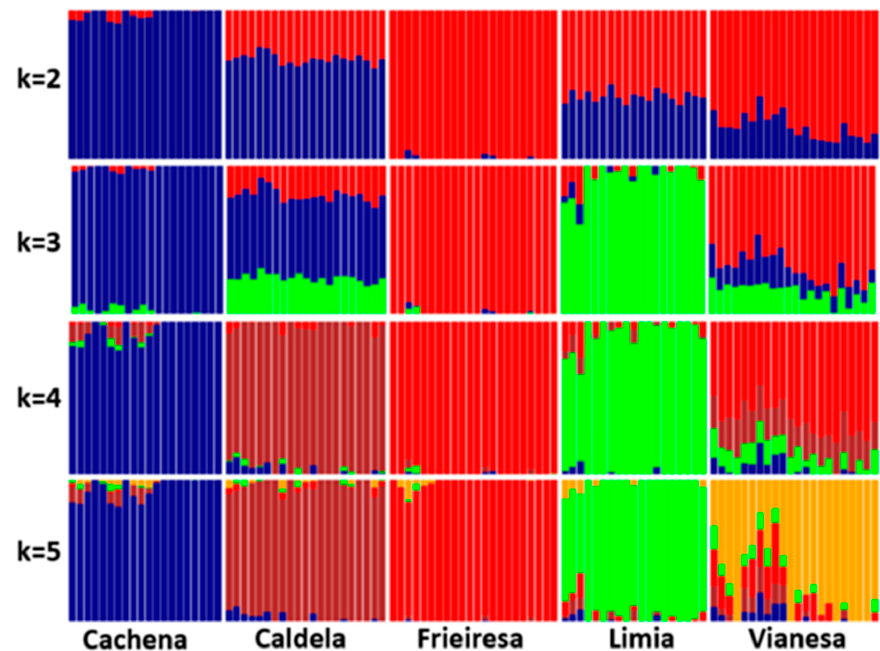
Figure 3. Population structure of Morenas Gallegas bovine breeds (Cachena, Caldelá, Frieiresa, Limiá, and Vianesa), inferred by using ADMIXTURE software. Each animal is represented by a single vertical bar divided into K colors, where K is the number of assumed ancestral clusters, which is graphically represented for K = 2–5.